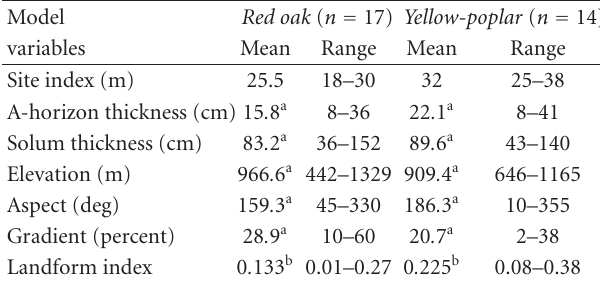
Table 1: Mean and range of site index, soil, and topographic variables by species for stands sampled in the Southern Appalachian Mountains of North Carolina, USA.